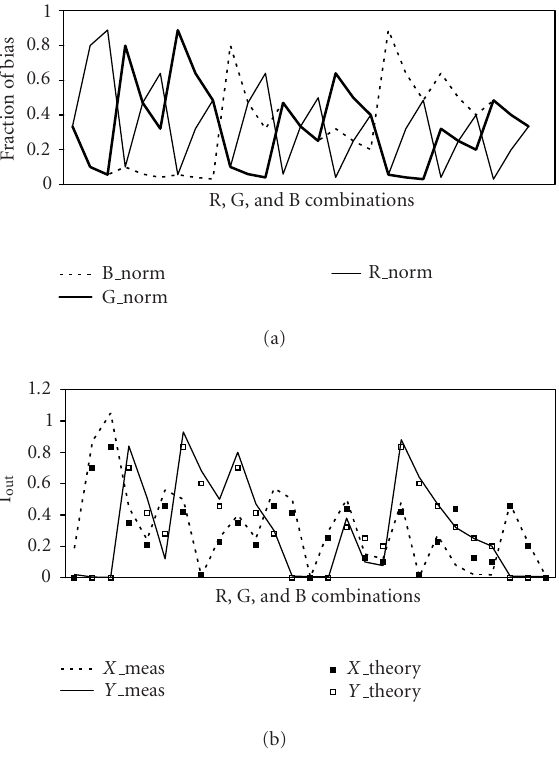
Figure 9: (a) shows the normalized rgb for various values of RGB. (b) shows the color opponents X = 2R − G − B and Y = G − B.